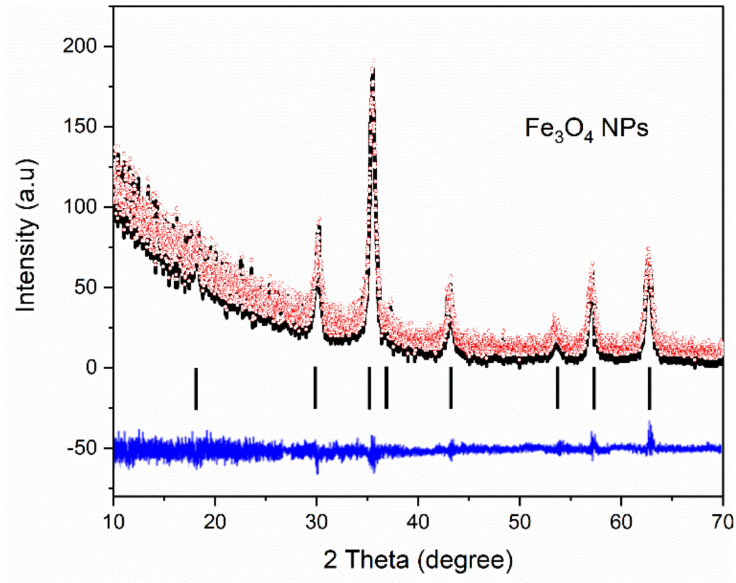
Figure 6. Rietveld refinement of the Fe 3 O 4 -PAA